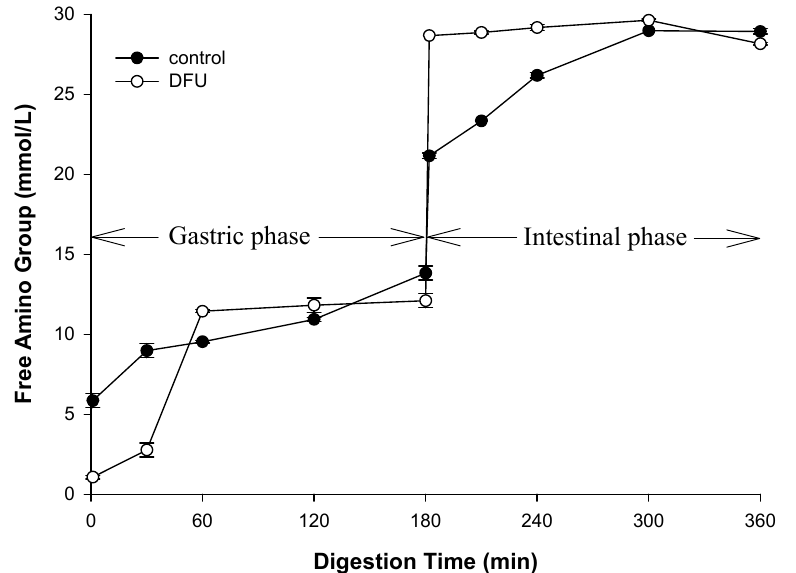
Figure 5. Free amino group released fromcontrol andDFU treated WPEG during simulated gastric digestion.